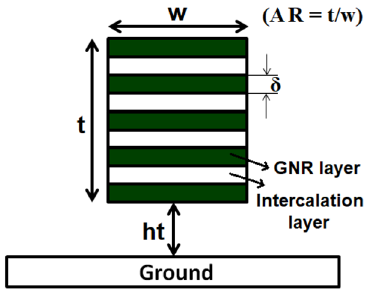
Figure 1. Structural representation of doped MLGNR interconnect.